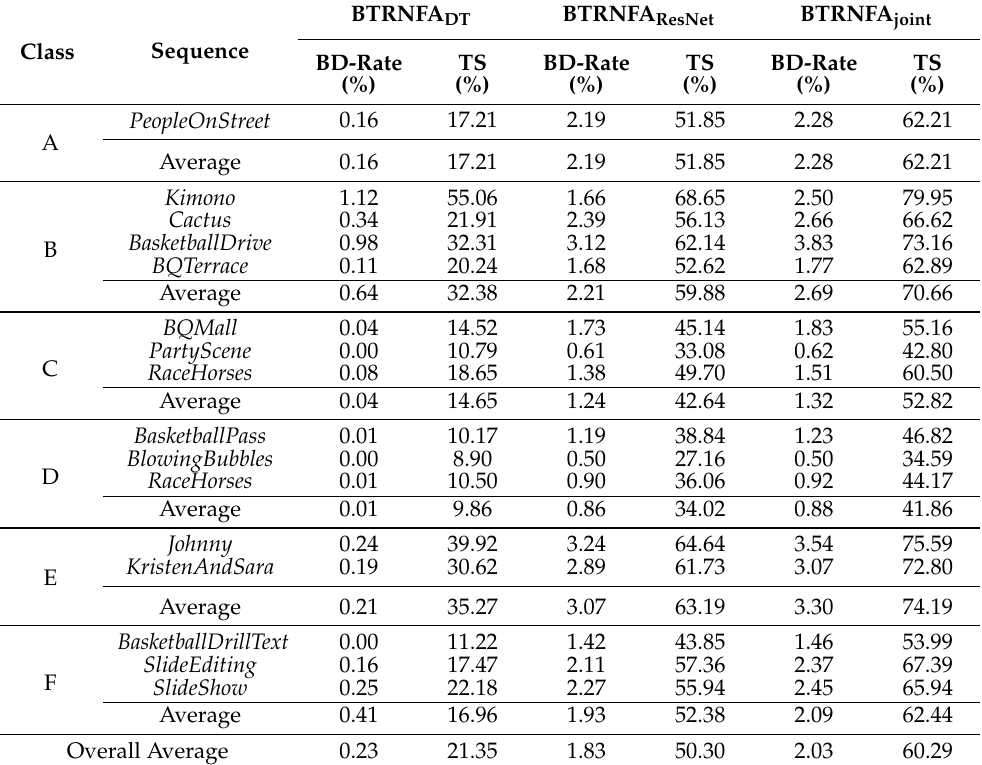
Table 4. BD-rate loss and time-saving performance of three versions of the proposed